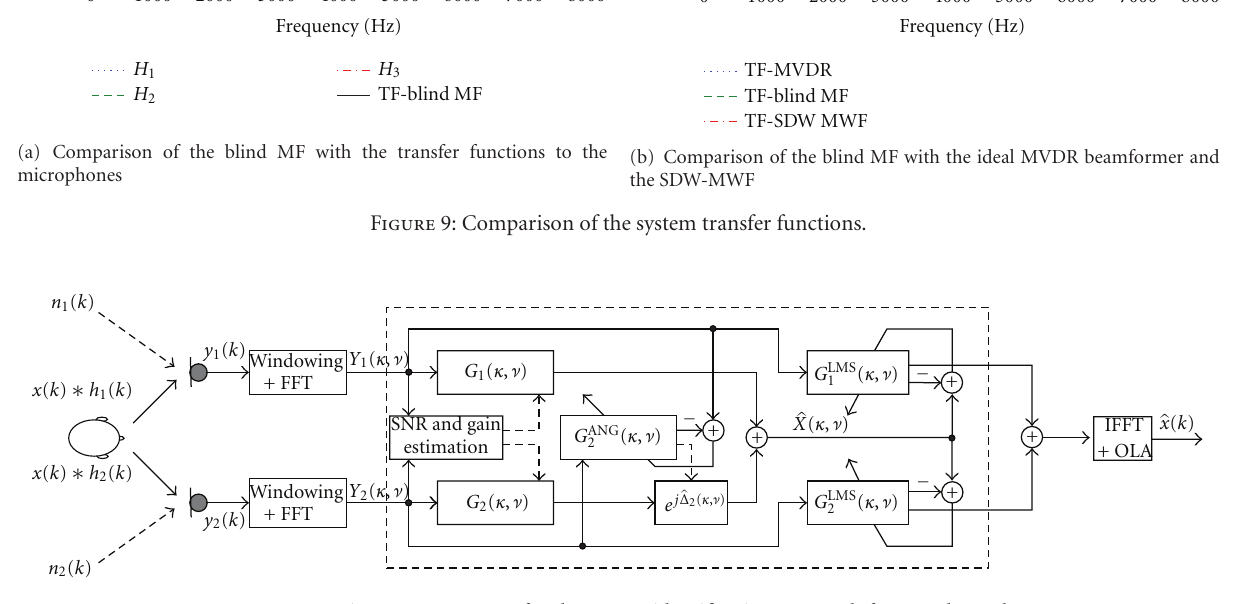
Figure 10: Basic system structure for the system identification approach for two channels.